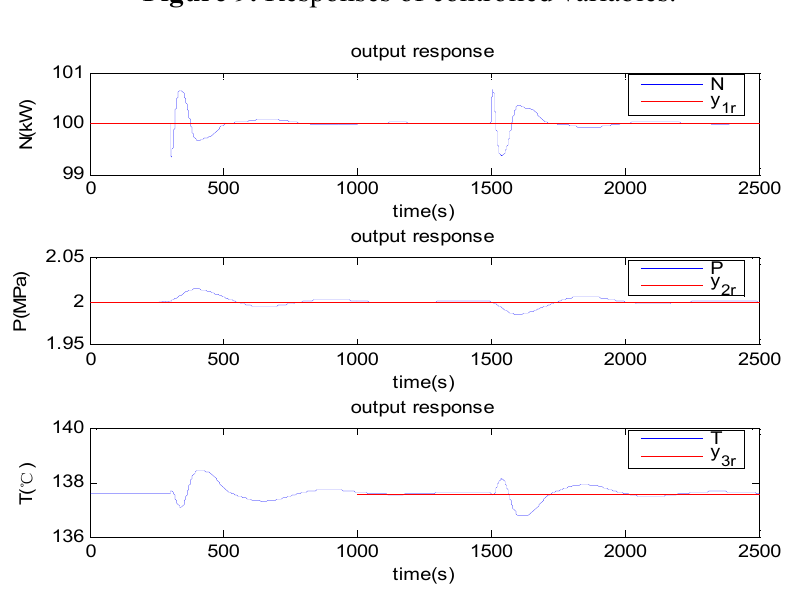
Figure 9. Responses of controlled